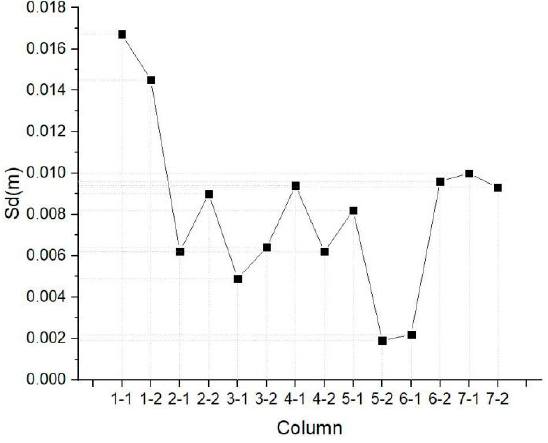
Figure 8. Standard deviation of each column.